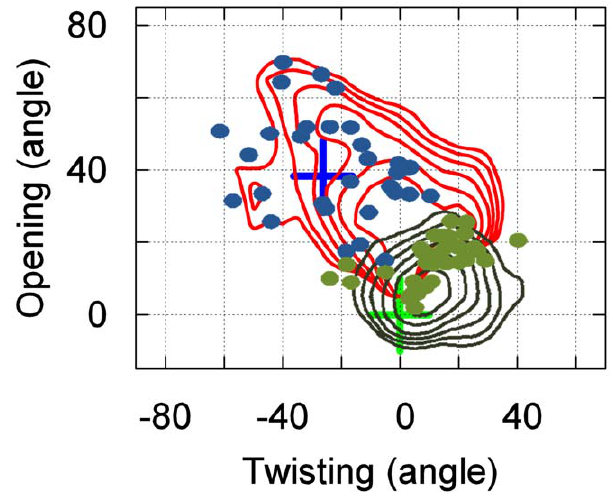
Figure 6. Overlay of free energy plots of the protein opening angle versus twisting angle for the encounter complex (red) and bound state (blue). Green dots correspond to where transitions from the encounter complex to the bound state occur. Blue dots correspond to where transitions into the encounter complex from other states occur. Only transitions without re-crossing are counted (minimum residence time in the final state after the transition is 6 ns).